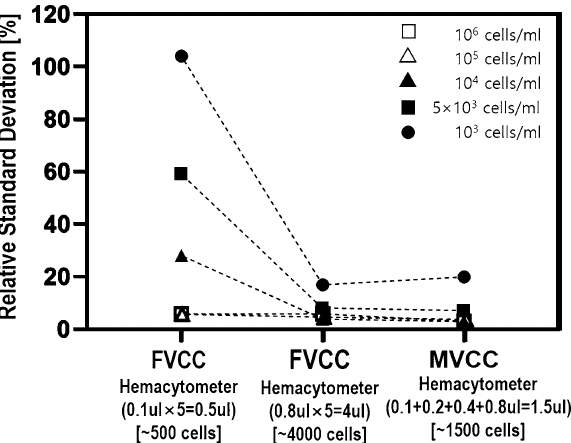
Figure 4. Comparison of the percent of relative standard deviation of cell number in each concentration between a standard hemacytometer and a multi-volume hemacytometer with four chambers and the MVCC